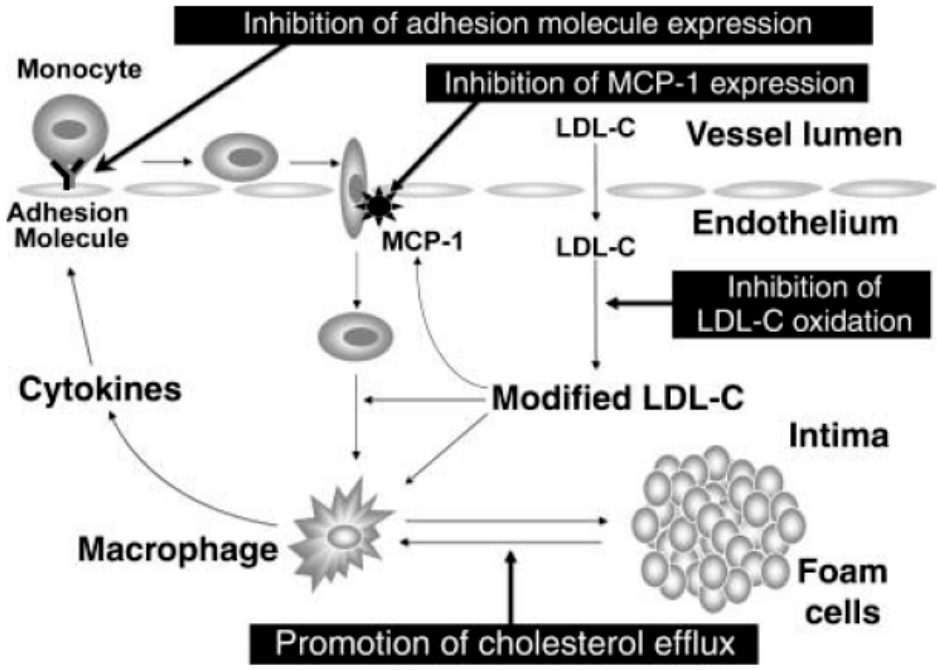
Figure 3. Role of low-density lipoproteins (LDLs) and early stages involved in atherosclerosis. Figure reproduced with permission from Barter [91]. LDL-C: LDL-cholesterol; MCP-1: Monocyte chemotactic protein-1.